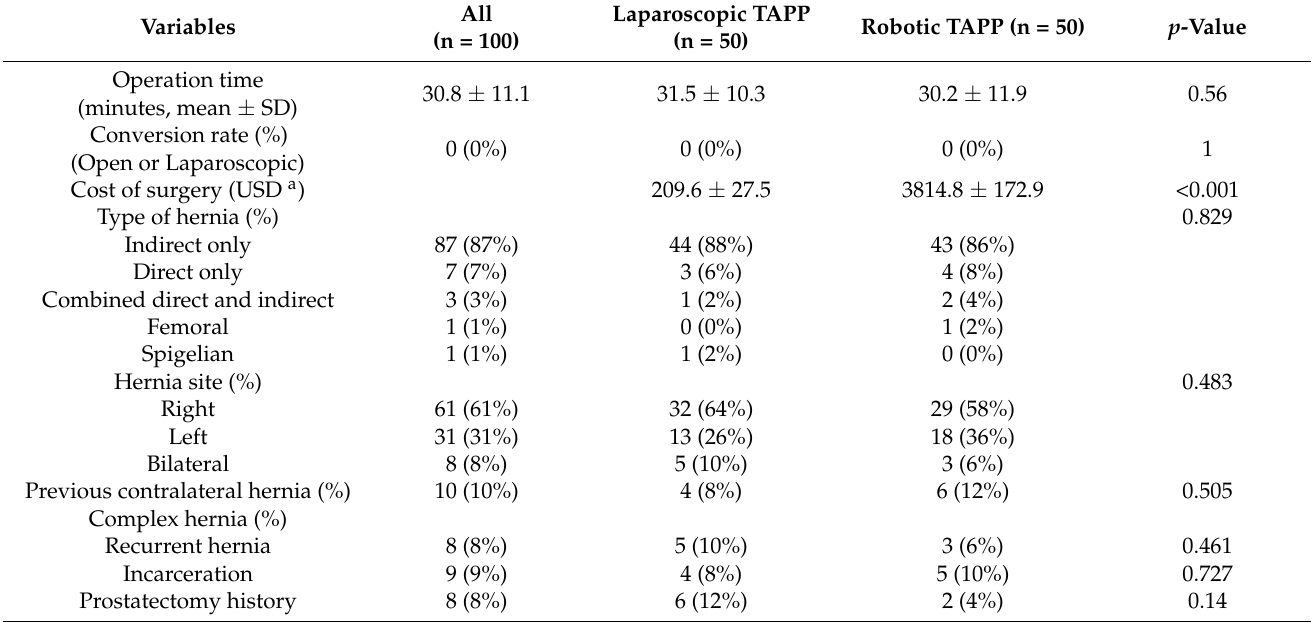
Table 2. Intraoperative